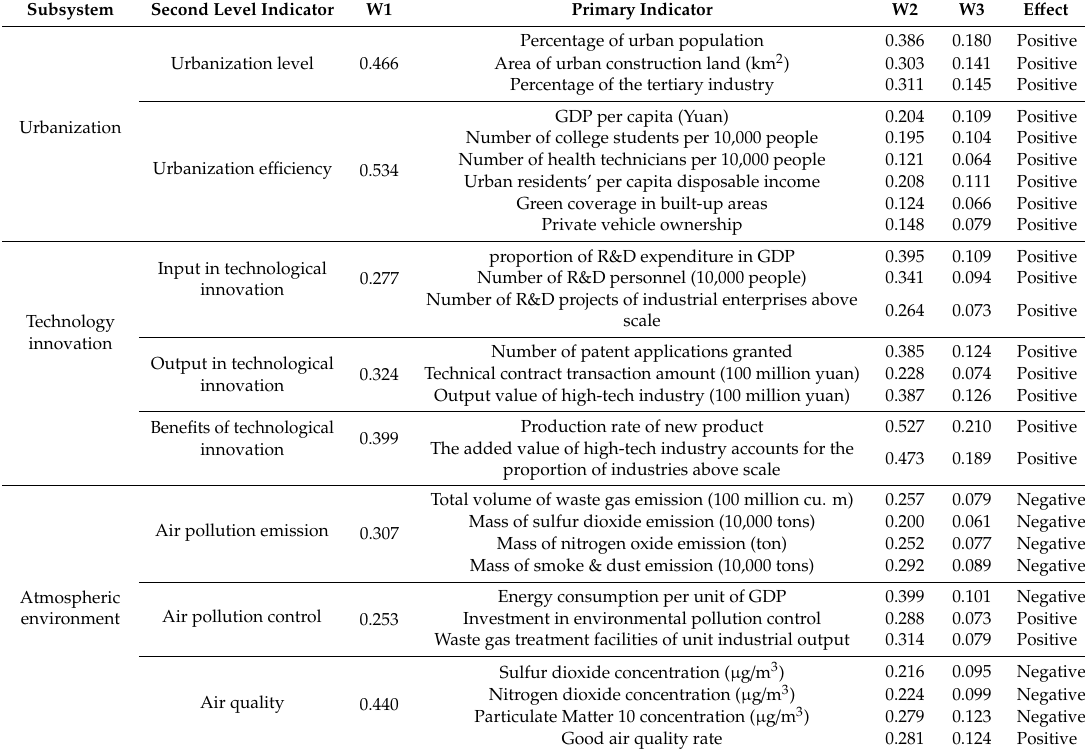
Table 1. Indicators of urbanization, technology innovation, and atmospheric environment subsystems in